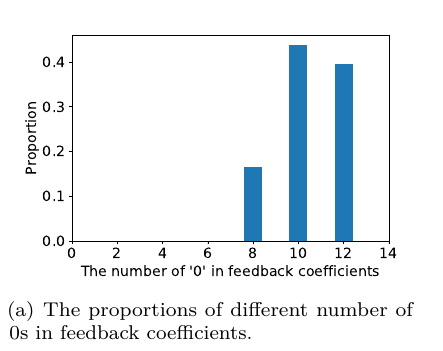
Figure 18: The statistics of the feedback polynomials with measured periodic oscillations and the sampled values of O 0 14